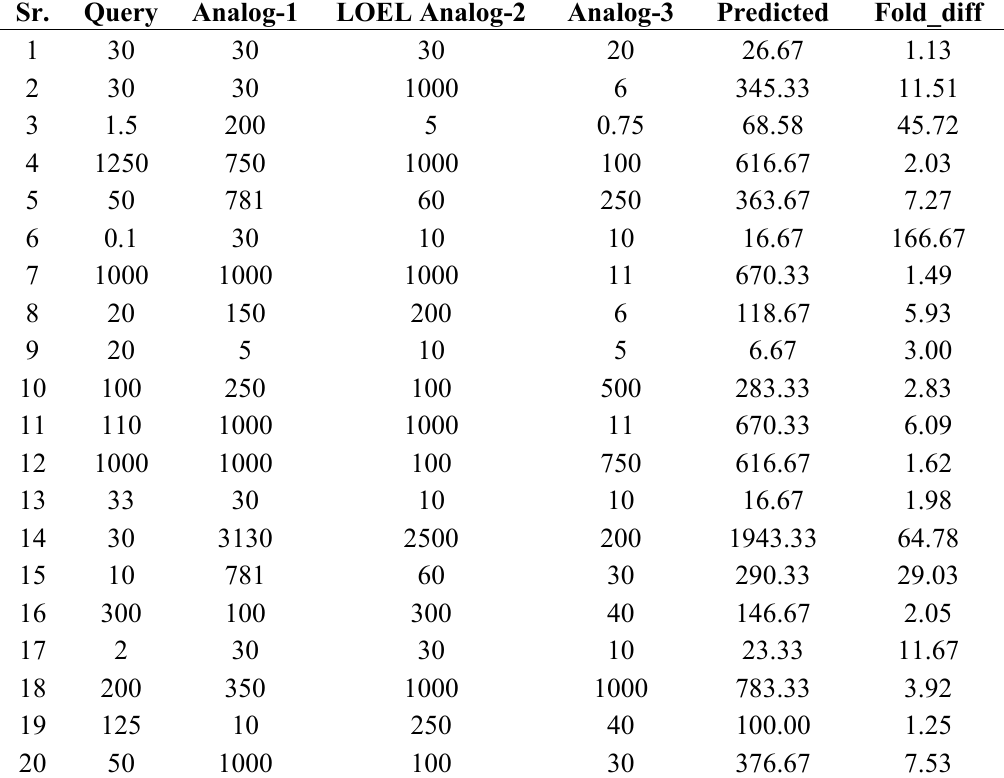
Table 3. Summary of predicted LOELs of all test set queries from the Estate fingerprint-based k -NN